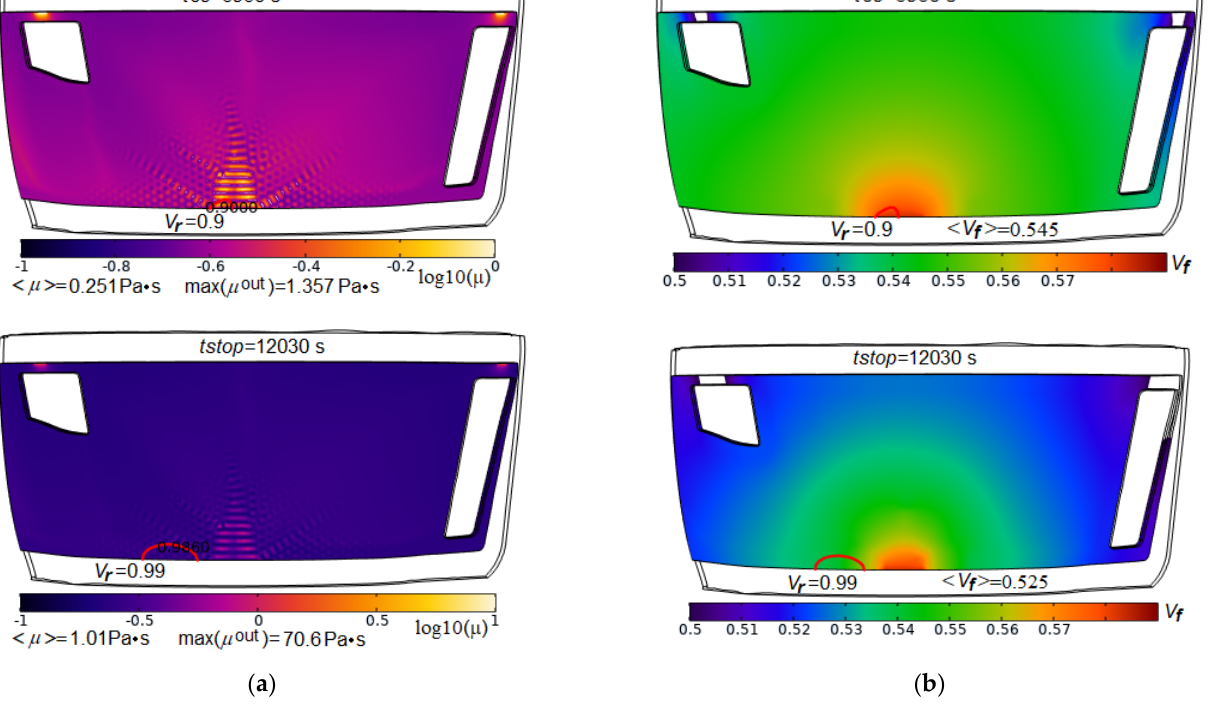
Figure 17. Screenshots of the spatial distributions for the logarithm of local resin viscosity ( a ) and fiber volume fraction ( b ) in partially filled domain at the time instants t 09 and tstop . Red solid lines indicate the resin front positions with filling V r = 0.9 (upper pictures) and V r = 0.99 (lower pictures),